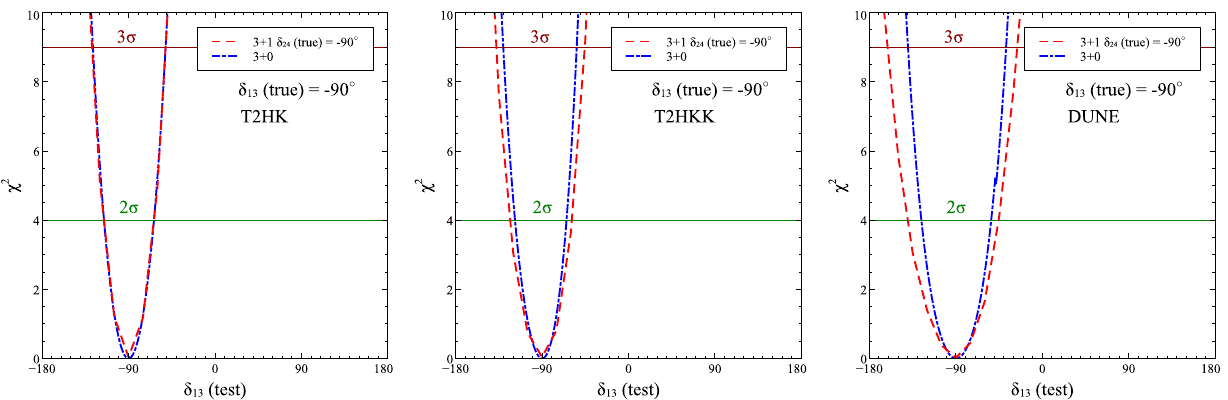
Fig. 4 The expected precision on δ 13 for the 3 + 0 and 3 + 1 scenarios. The left panel is for T2HK, the middle panel is for T2HKK and the right panel is for DUNE. The blue dash-dotted curves are for the 3 + 0 case